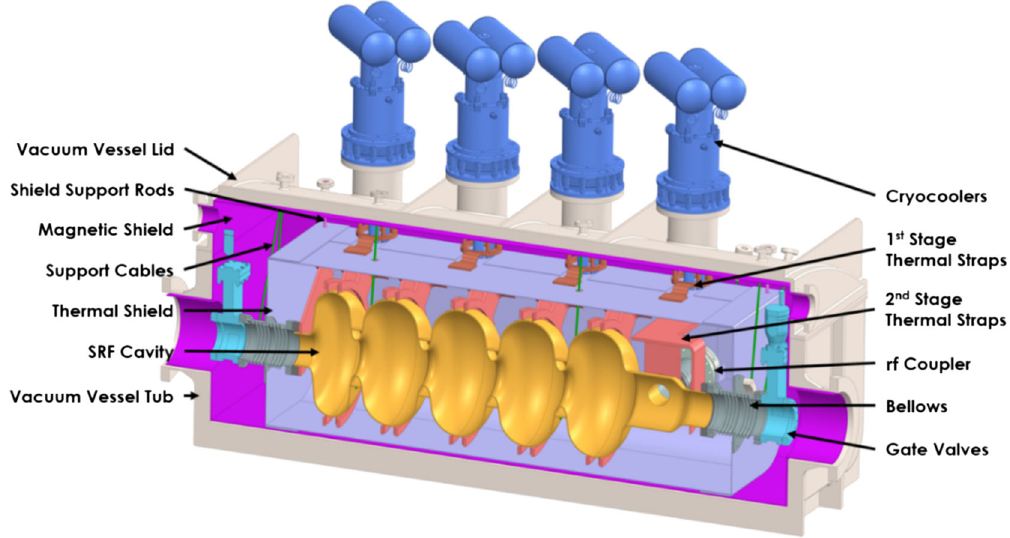
FIG. 19. Cross-section view of the SRF cryomodule assembly. The end-to-end length is 1.95